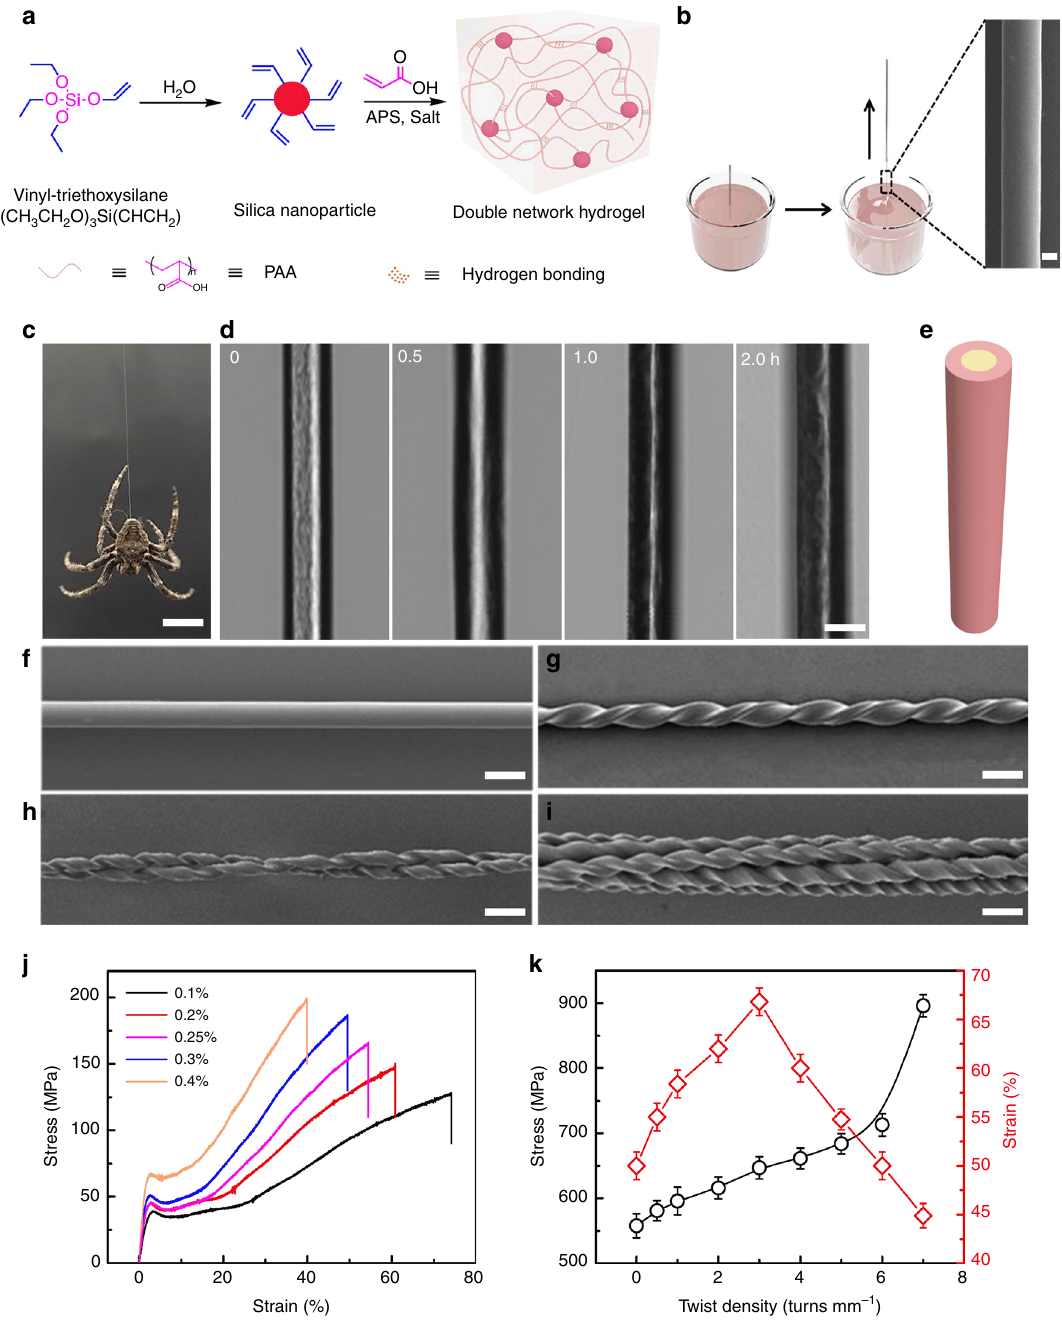
Fig. 1 Preparation, morphology and mechanical strength of hydrogel fi bres. a Two-step synthesis of hydrogel involving VSNP formation and free-radical polymerisation. b A single fi bre was drawn by dipping a steel rod into a hydrogel reservoir. The diameter of the steel rod was 0.2 mm, and the drawing speed was 4 cm s − 1 . Scale bar: 10 μ m. The hydrogel fi bre shown in the micrograph contained 0.1 wt% VSNPs, without salt or inserted twist, and had a diameter of 20 μ m. It was obtained at an atmospheric relative humidity of 40%. c An Araneus diadematus spider hanging on a strand of natural spider silk; the scale bar is 2 cm. d Laser confocal microscope images of hydrogel fi bres with different drying times. Scale bar: 20 μ m. e Core-sheath model of the hydrogel fi bre. f – i SEM images of non-twisted ( f ), twisted ( g ), self-balanced, 2-ply ( h ), and self-balanced, 6-ply hydrogel fi bres ( i ). The scale bars for d – i are 20 μ m. The twist density was 7 turns mm − 1 . j Tensile stress-strain curves of the as-drawn hydrogel fi bres with different VSNP contents after shape setting. The hydrogel fi bres contained 0.1 – 0.4 wt% VSNPs, without inserted twist or salt. The deformation rate was 1.1% s − 1 . k Breaking stress and breaking strain of hydrogel fi bres with optimised mechanical properties as a function of twist density at a deformation rate of 27.8% s − 1 . In d , f – i and k , the hydrogel fi bres contained 0.1 wt% VSNPs and 20 mM ZnCl 2 . The error bars mean the s.d. from fi ve